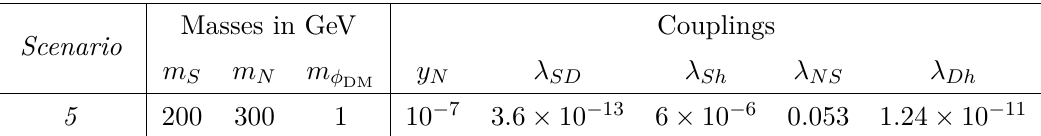
Figure 8 . The figures correspond to Scenario-4 . Figure 8(a) shows the relativistic reaction rates for the process hh, SS → φ , and h, S → φ ∗ φ D . Figure 8(b) shows the individual contributions D φ D D to the relic density, and the total relic density. The brown horizontal line represents the present experimentally measured relic density [54]. Figure 8(c) shows the relative enhancement in the relic density with respect to Maxwell-Boltzmann distribution.